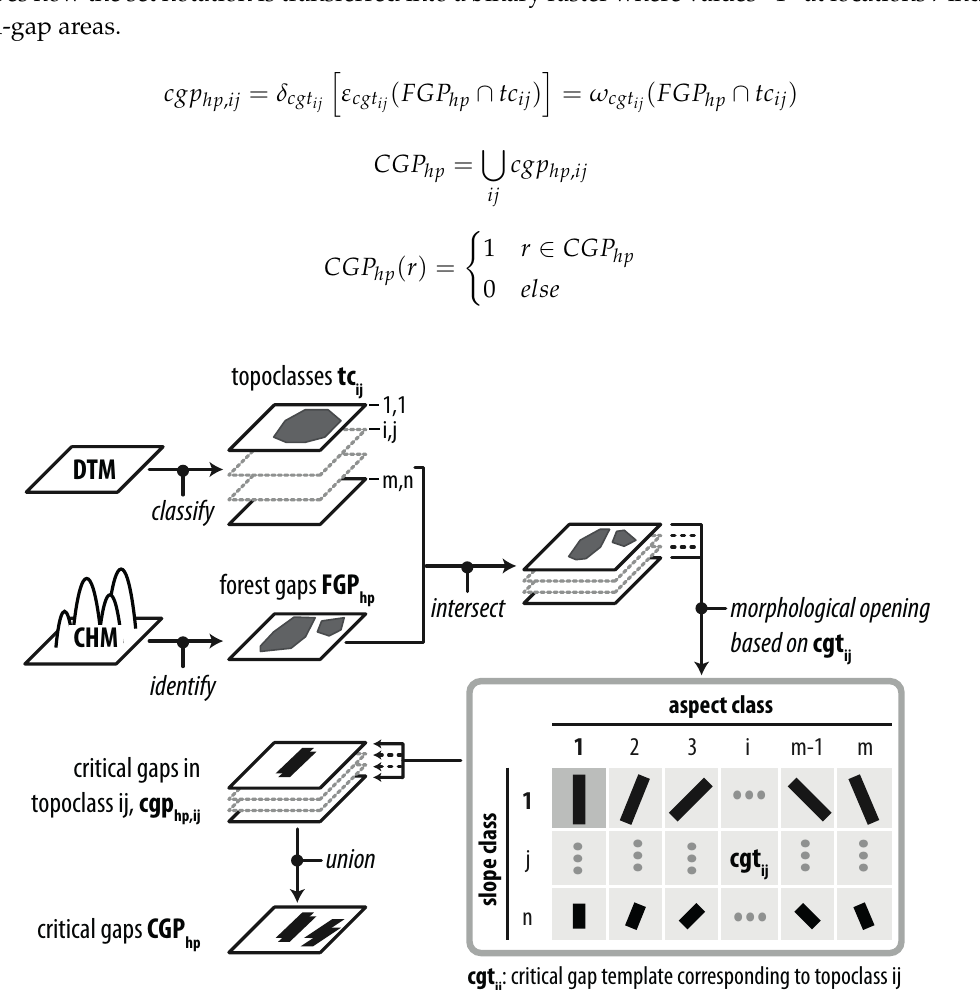
Figure 1. Workflow for the automatic detection of critical forest gaps ( CGP hp ) based on a series of morphological opening operations applied to forest gaps ( FGP hp ) for various topoclasses ( tc ij ) and their corresponding critical-gap templates ( cgt ij ). Topoclasses are computed from the digital terrain model (DTM) and forest gaps from the canopy height model